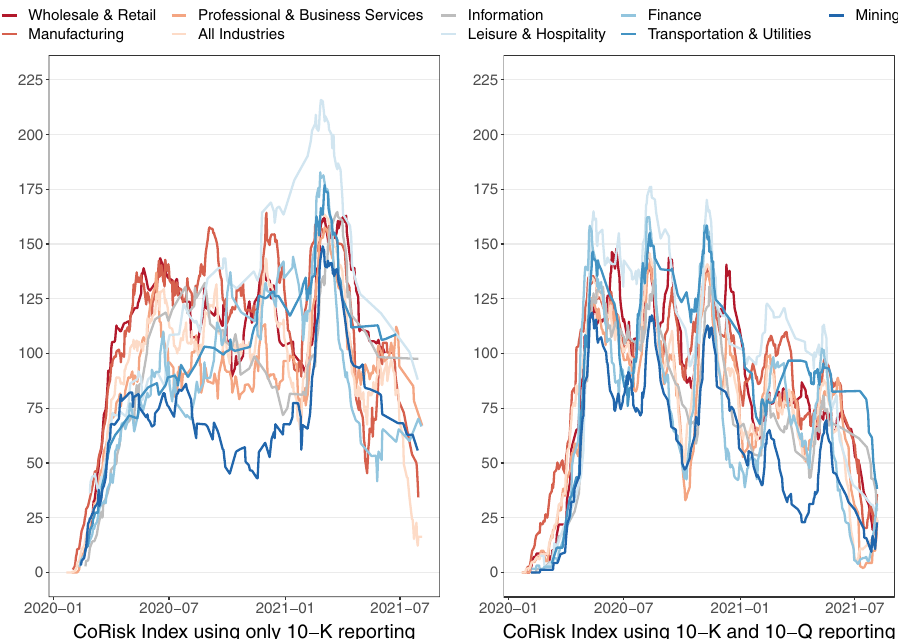
Fig. 5 The CoRisk-Index based on 10-K reports (left panel) and on 10-K and 10-Q reports (right panel). The indices show some similarity, however the index on the right is biased by the very high number of 10-Q reports being fi led in May